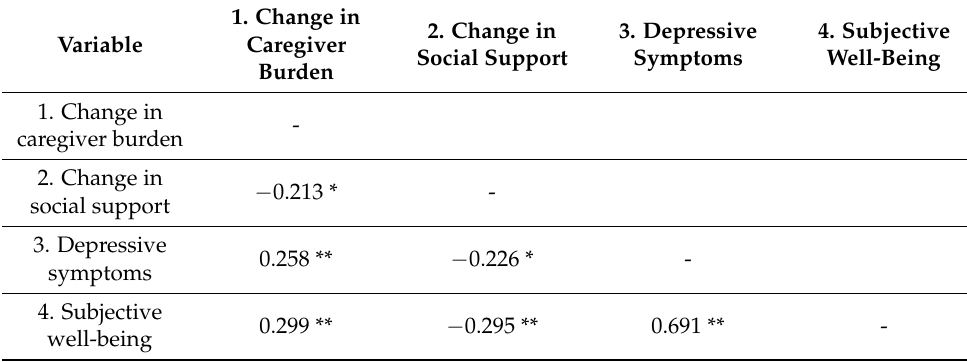
Table 3. Correlations between variables of the present study ( n = 101).